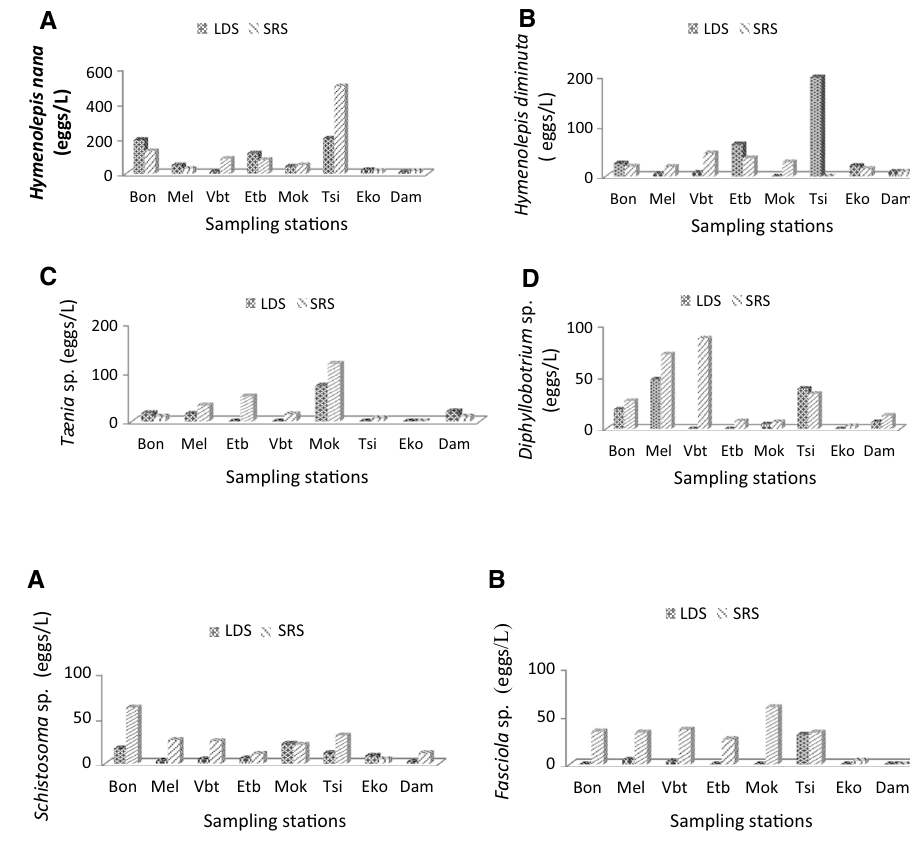
Fig. 7 Seasonal variation of the density of trematodes